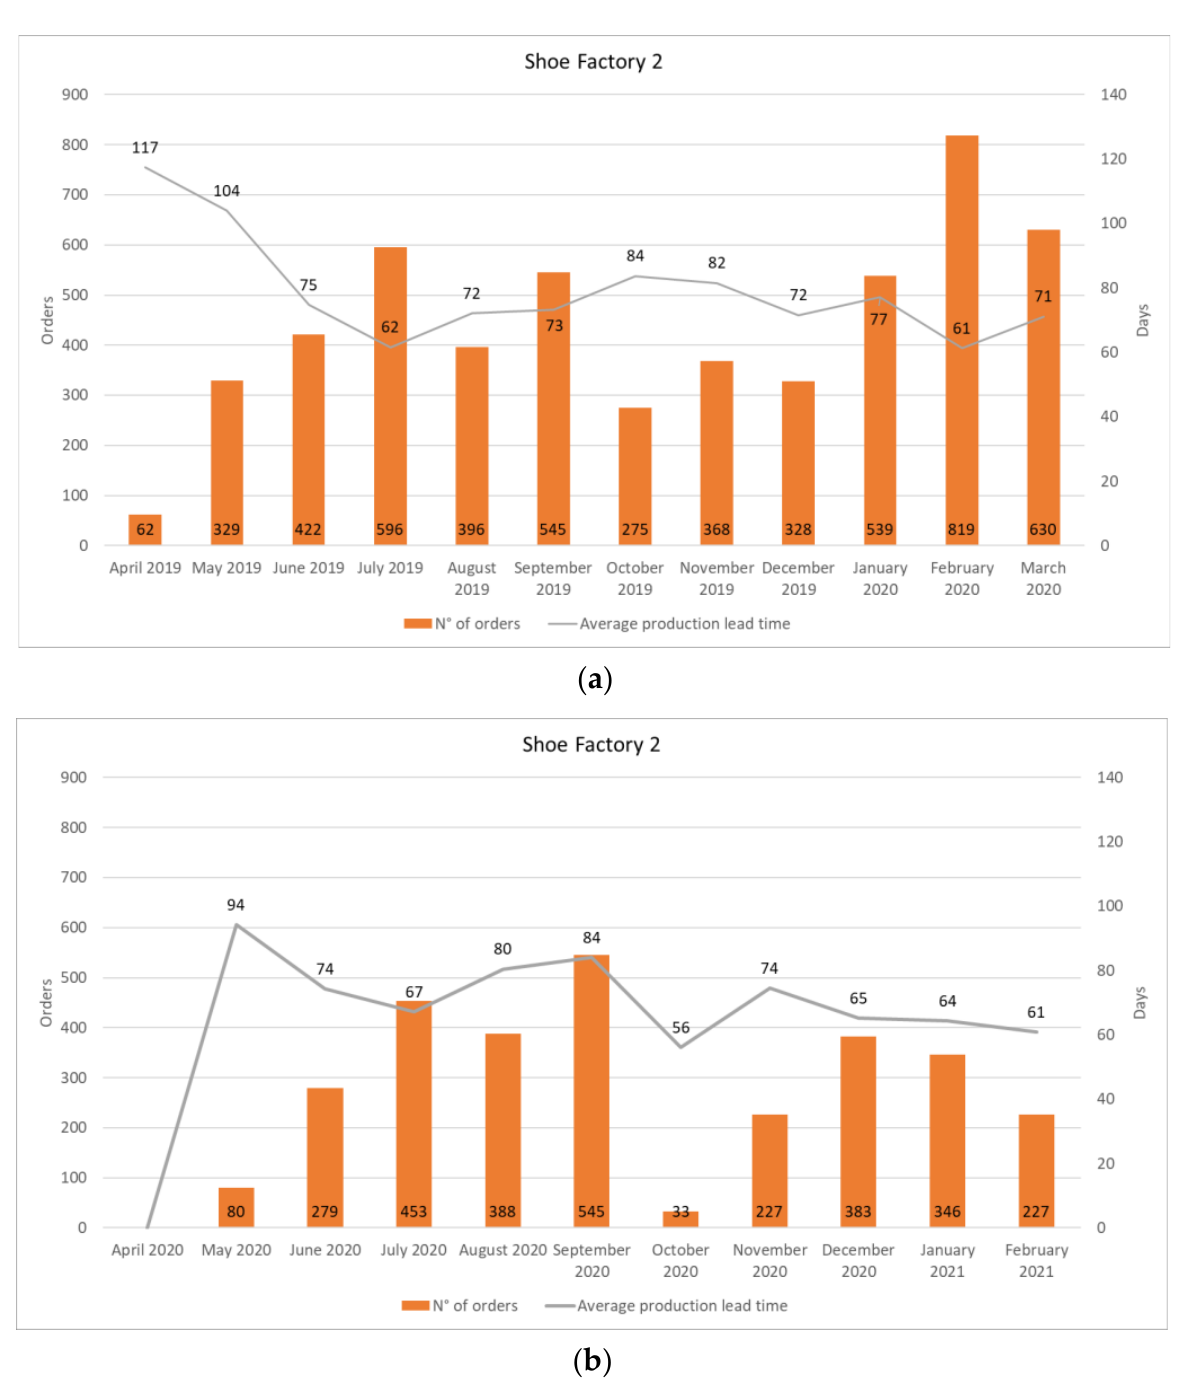
Figure 4. Shoe factory 2—monthly average production lead time, and N ◦ of orders, considering AW19-SS20 seasons ( a ) and AW20-SS21 seasons ( b ).